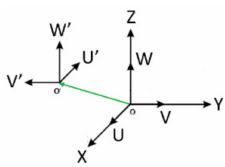
Figure 1. System “ouvw” rotated and translated with respect to